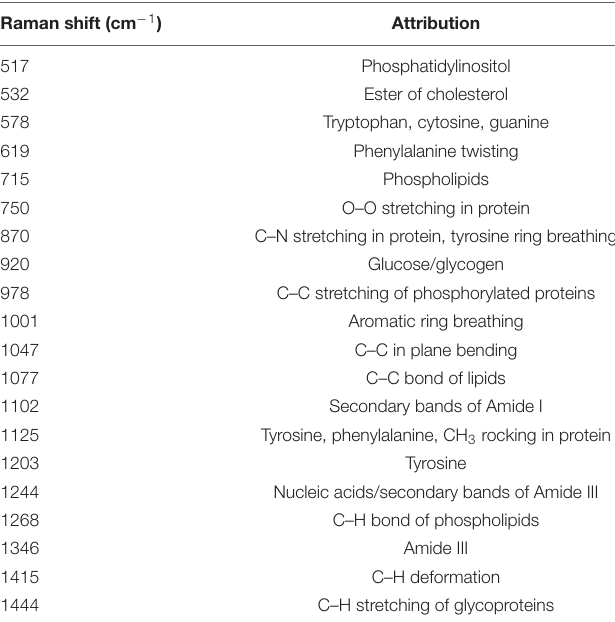
TABLE 2 | Attribution of the most prominent peaks obtained from Raman salivary analysis ( ± 8 cm − 1 ), based on reported literature (Movasaghi et al., 2007; Gonchukov et al., 2012; Muro et al.,